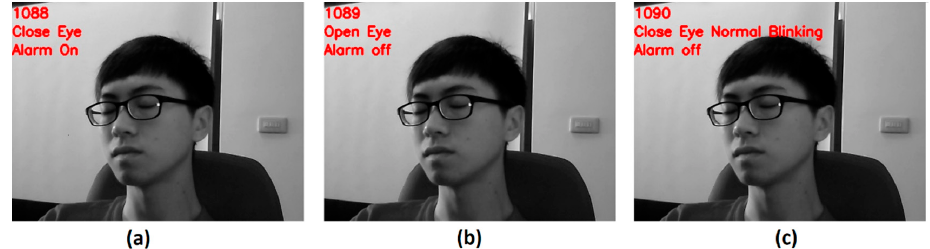
Figure 13. An example of isolated prediction error on three consecutive frames. ( a ) Classified as driver drowsiness; ( b ) isolated error caused by an environmental nonuniformity; and ( c ) classified as normal blinking due to isolated error in the previous frame ( b ).